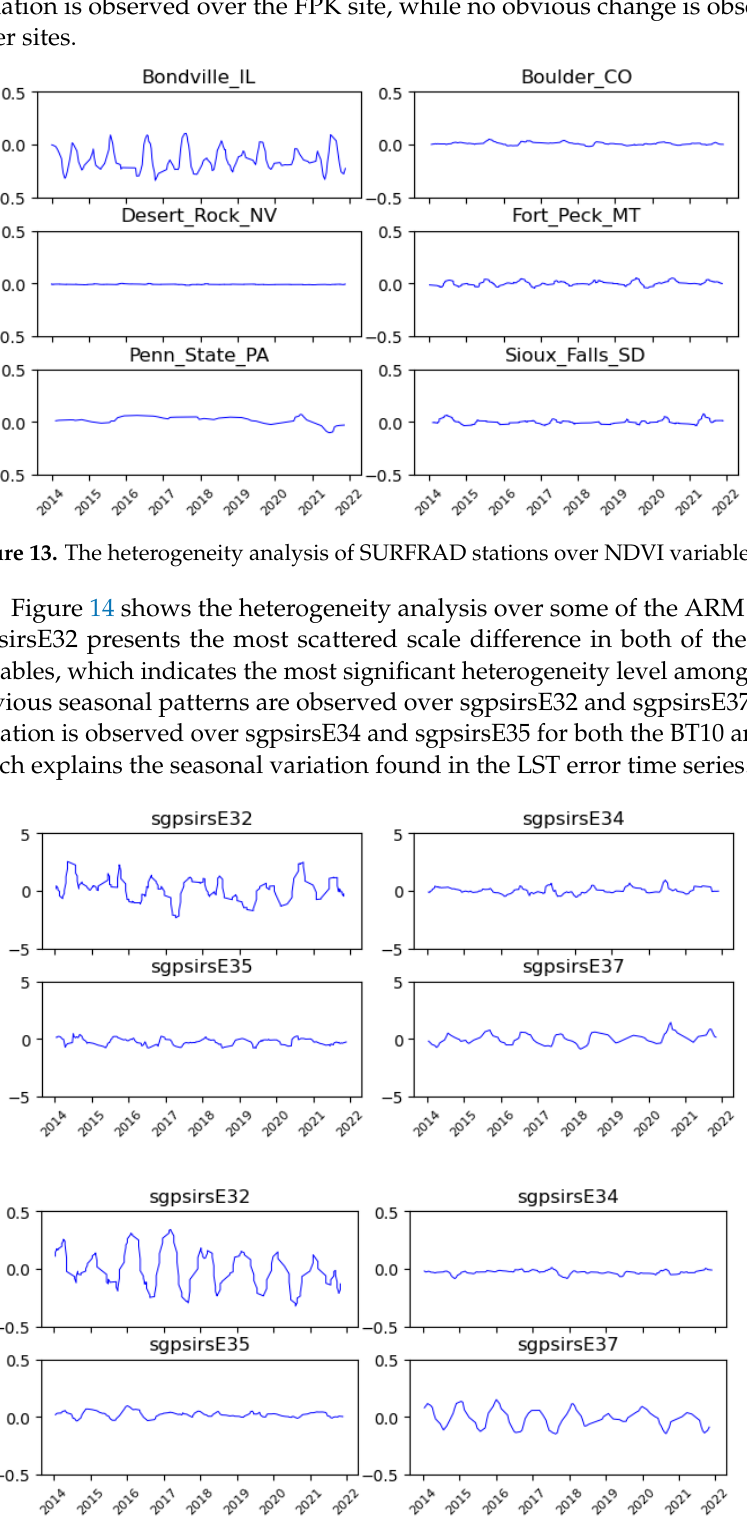
Figure 14. The heterogeneity analysis of some ARM stations over BT10 ( top ) and NDVI variable ( bottom ).